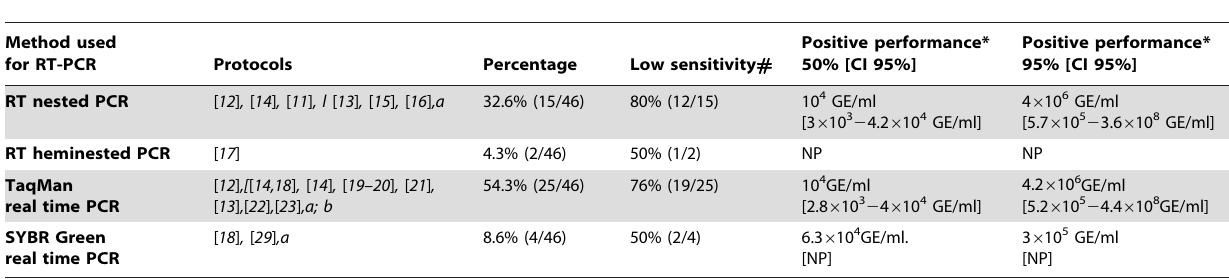
Table 2. Probit analysis of the sensitivity profile of the different RT-PCR methods reported.